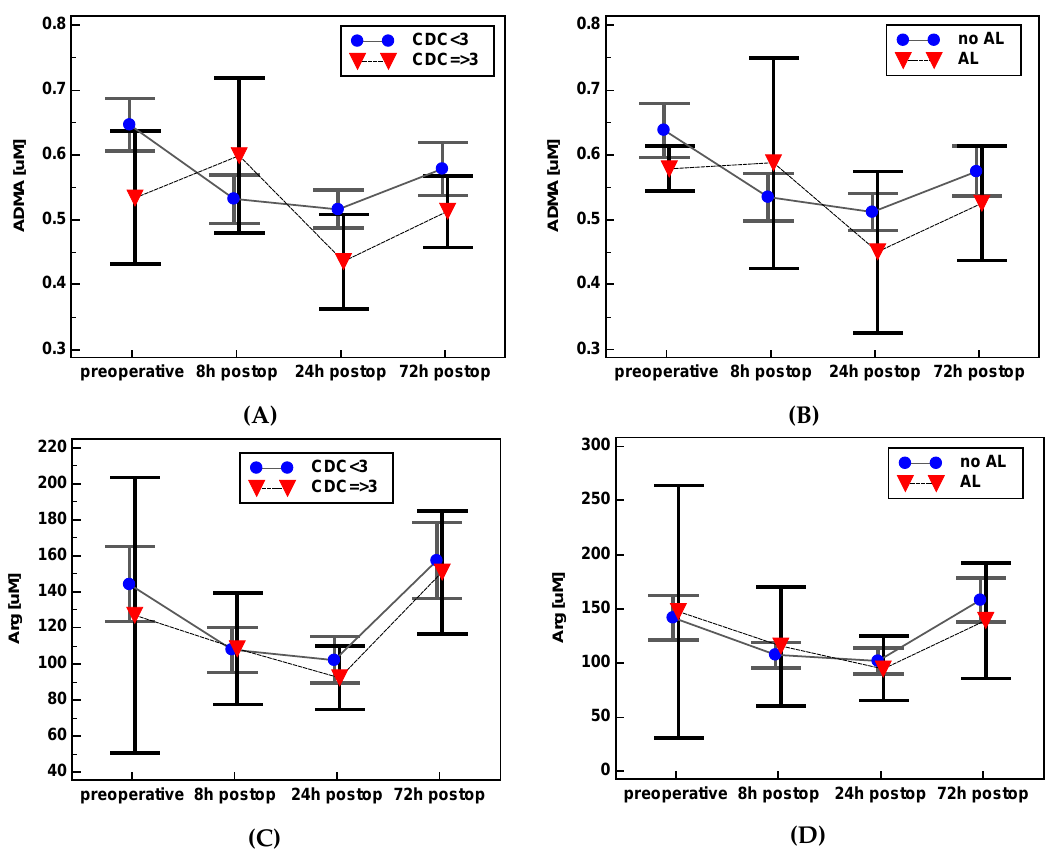
Figure 8. Association of postoperative dynamics of asymmetric dimethylarginine (ADMA) with postoperative complications: ( A ) Asymmetric dimethylarginine (ADMA) with the Clavien-Dindo Classification (CDC) of operative morbidity; ( B ) ADMA with anastomotic leakage (AL); ( C ) arginine (Arg) with CDC; ( D ) Arg with AL. Data presented as means with a 95% confidence interval and analyzed using repeated measures ANOVA. Postop: Postoperative.